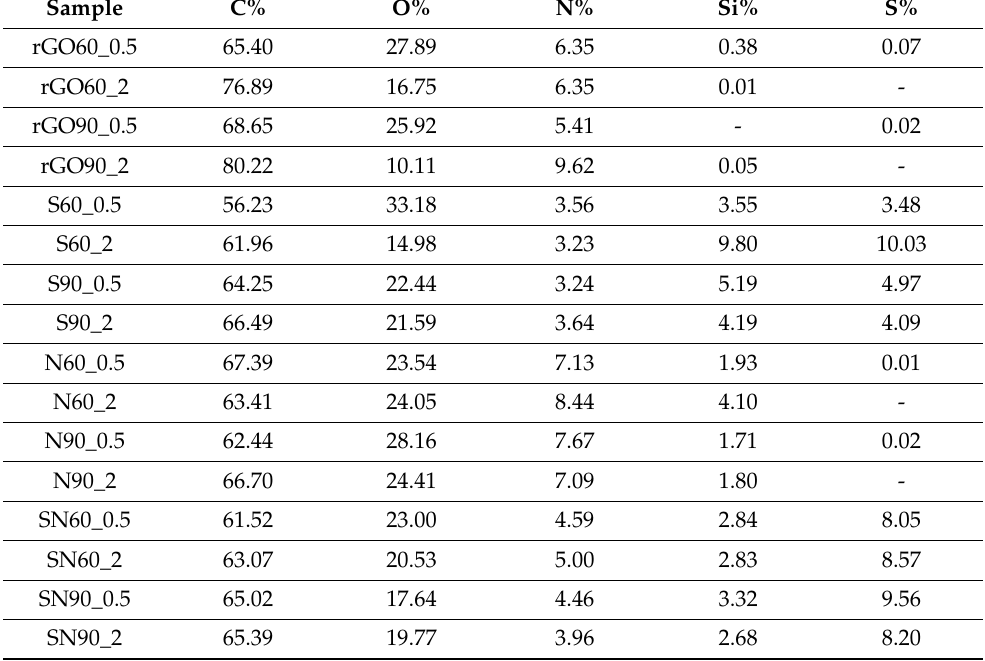
Figure 4. SEM images from all modified samples: ( a ) S60_0.5; ( b ) S60_2; ( c ) S90_0.5; ( d ) S90_2; ( e ) N60_0.5; ( f ) N60_2; ( g ) N90_0.5; ( h ) N90_2; ( i ) SN60_0.5; ( j ) SN60_2; ( k ) Sn90_0.5; ( l ) SN90_2. Table 2. EDX percentages from all